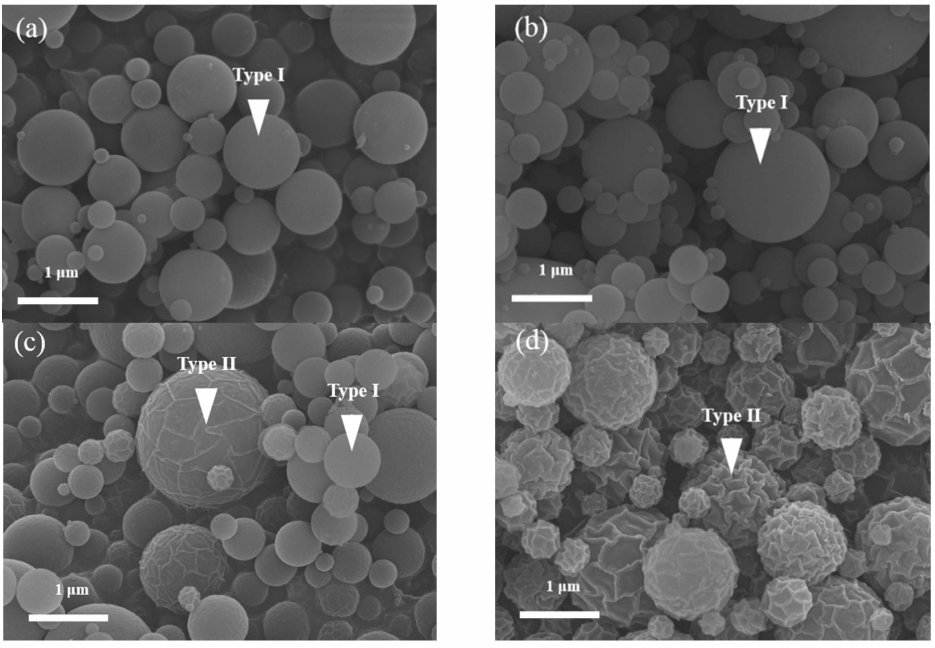
Figure 2. SEM images of MBG particles prepared using various surfactant concentrations of